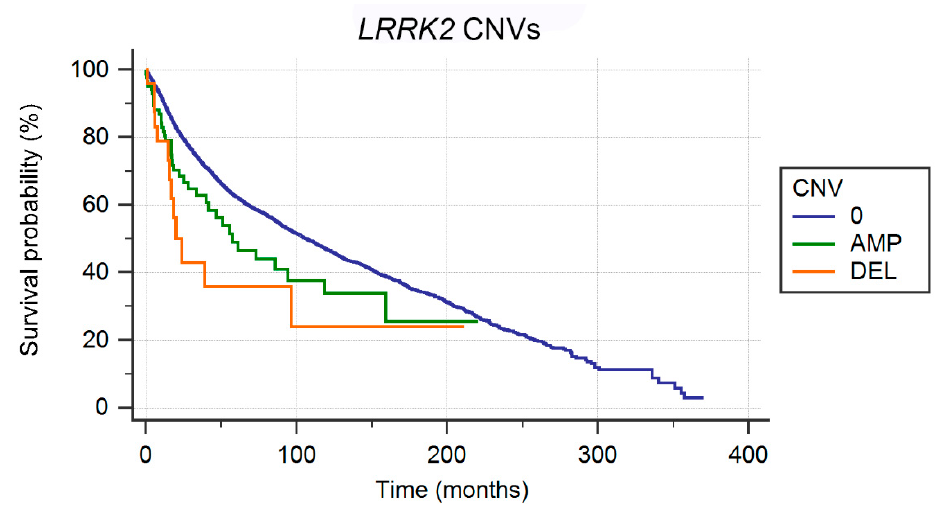
Figure 7. Survival of cases showing LRRK2 whole gene deletions (DEL, orange curve), amplifications (AMP, green curve), and no copy-number alterations (0, blue curve).